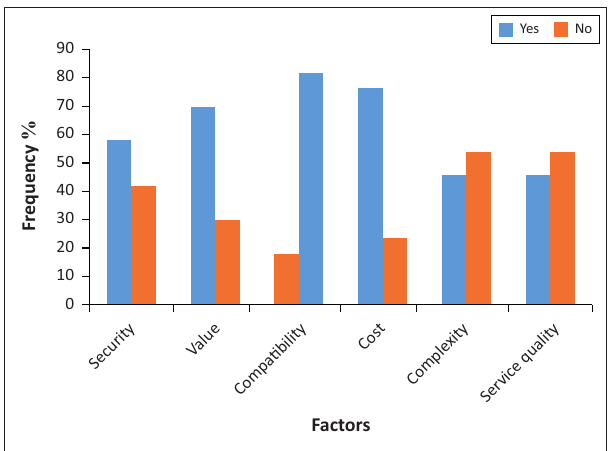
FIGURE 7: Technological factors.